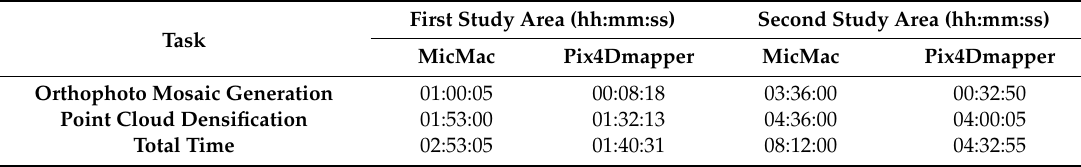
Table 2. Photogrammetric processing time in Pix4Dmapper and MicMac. First Study Area Task